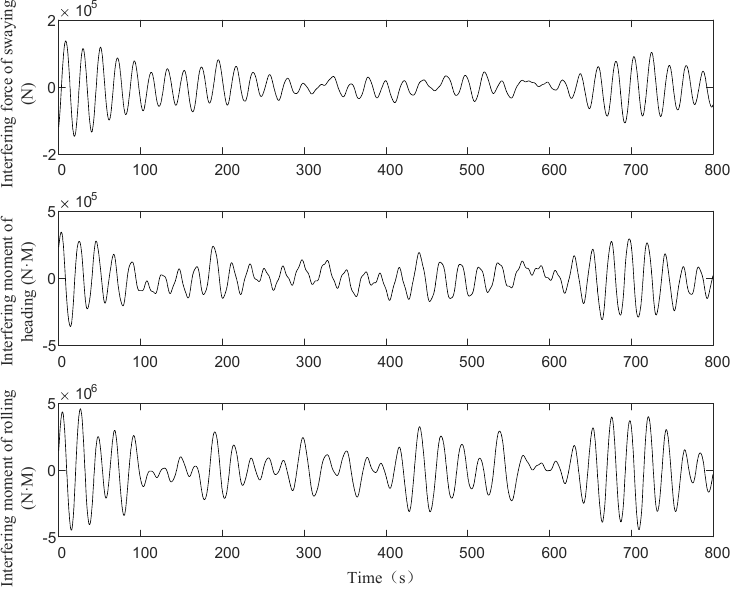
Figure 3. Force and moment of sea wave disturbance at 30 ◦ .